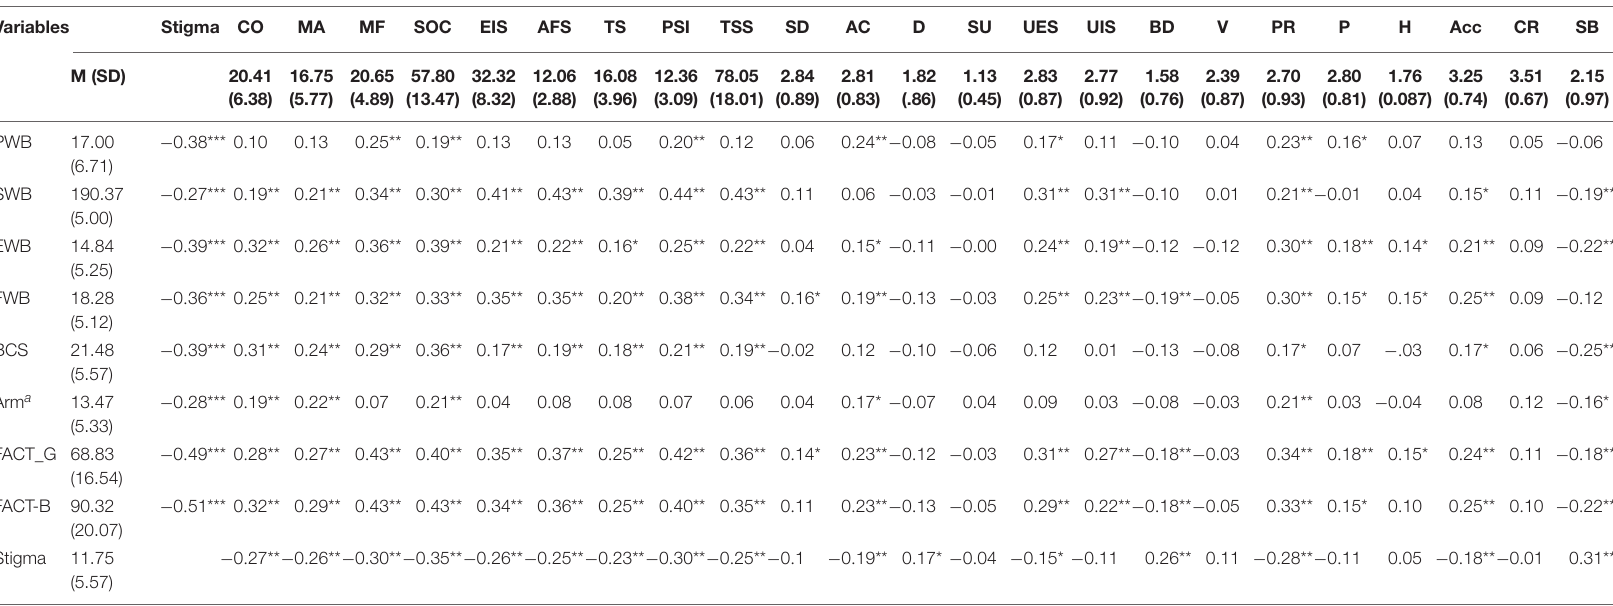
TABLE 2 | Correlation matrix between study variables ( N = 221).